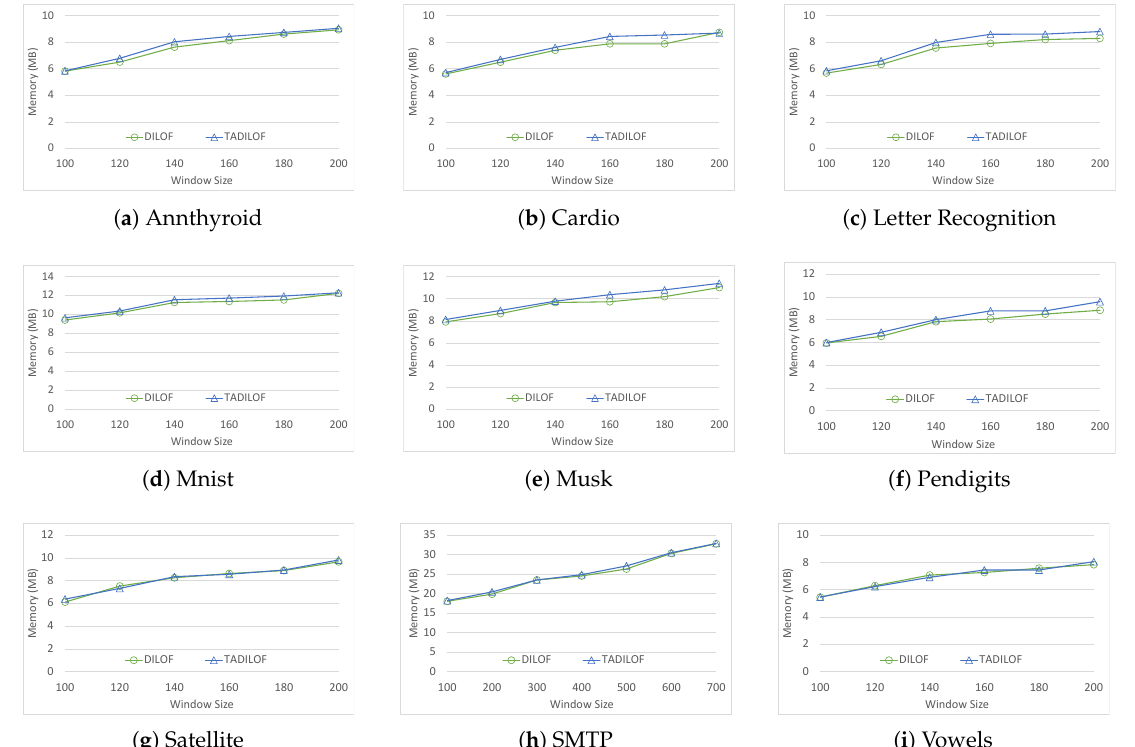
Figure 8. Memory usage on various datasets with different window sizes and K = 8.